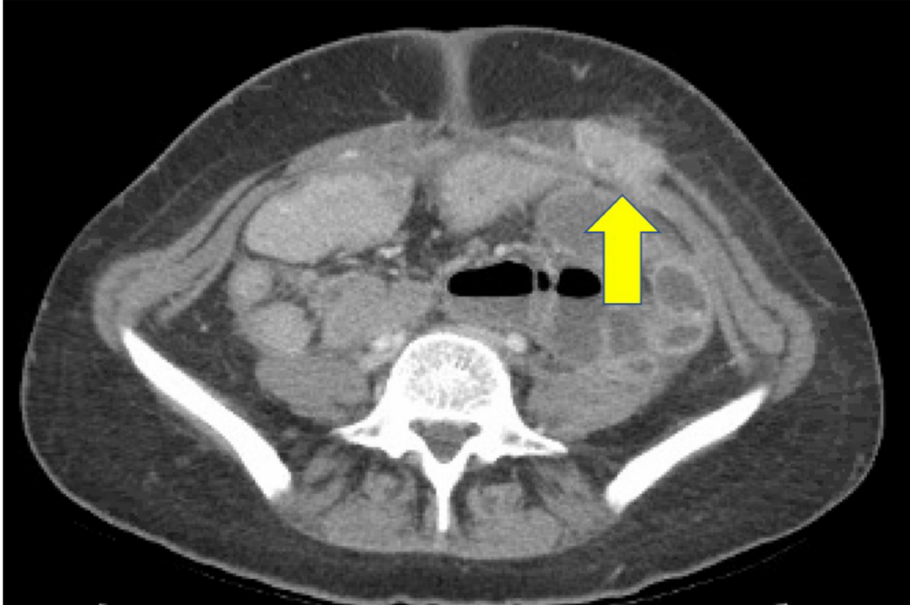
Figure 3. Axial CT image of case report patient demonstrated disease recurrence in left abdominal wall (yellow